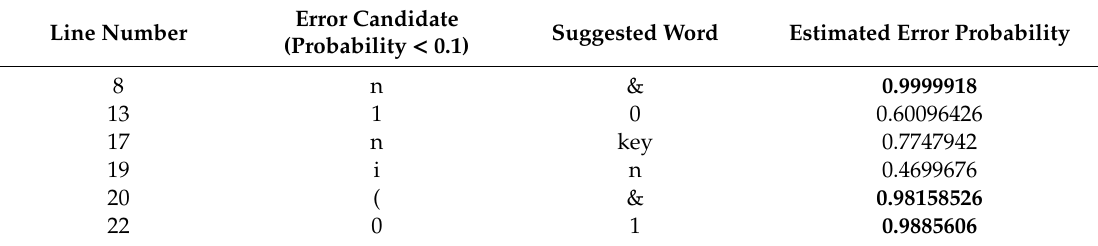
Table 3. Estimated error probability for source code in Figure 7.